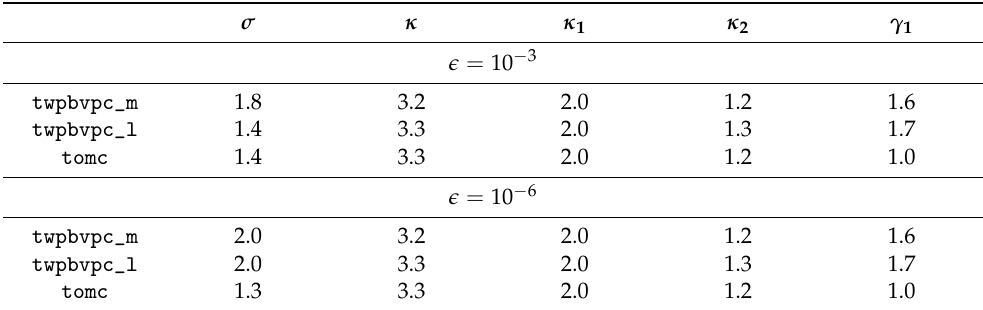
Table 15. Bang-Bang optimal control problem with penalty: conditioning parameters computed using tol = 10 − 6